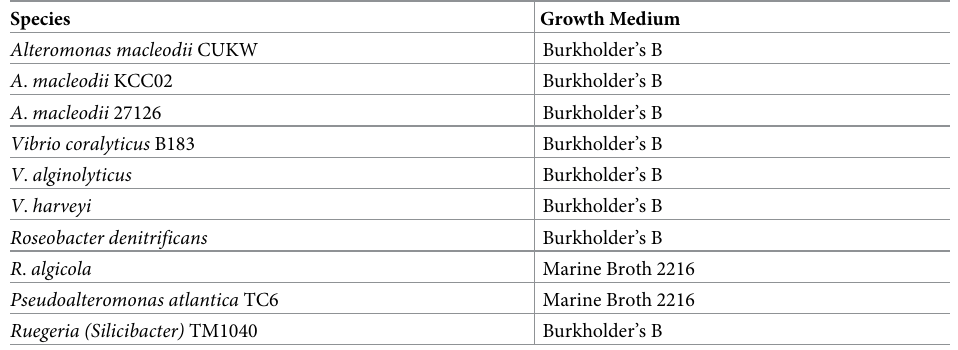
Table 1. Marine species included in copper resistance